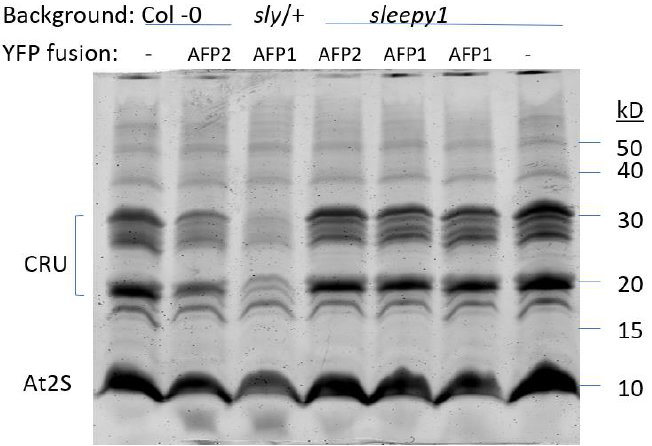
Figure 3. Storage protein accumulation in the indicated genotypes. Total seed protein extracts were separated on 15% SDS-PAGE and stained with Coomassie blue. Major bands represent cruciferin and At2S storage protein families.